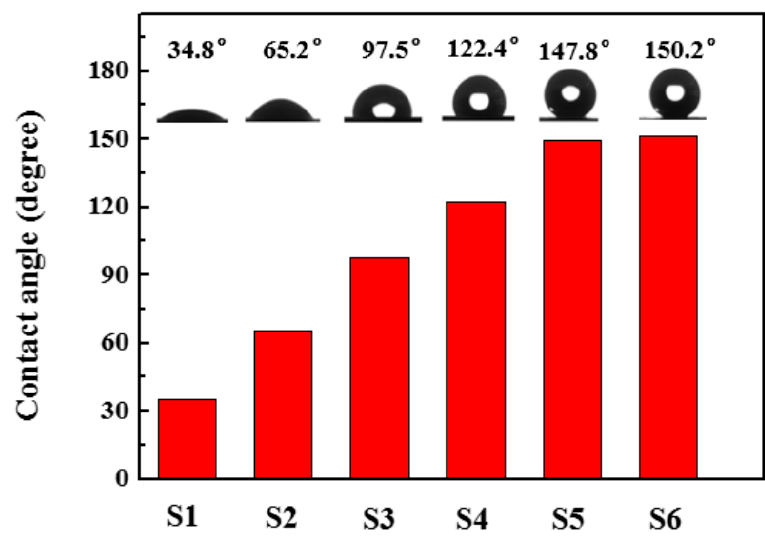
Figure 6. The water contact angle of various OS-modified AlN